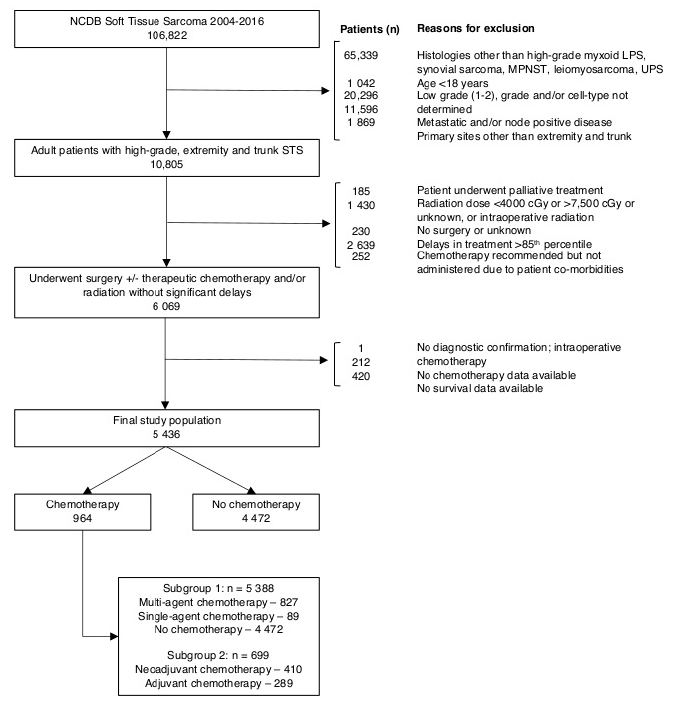
Figure 1. Consolidated Standards of Reporting Trials (CONSORT) diagram showing definition of study cohort from NCDB STS database. NCDB = National Cancer Database; STS = soft tissue sarcoma. Table 1. Characteristics of study cohort of adult patients with primary high-grade extremity and trunk STS in the NCDB from 2004 to 2016. NCDB = National Cancer Database; STS = soft tissue sarcoma.